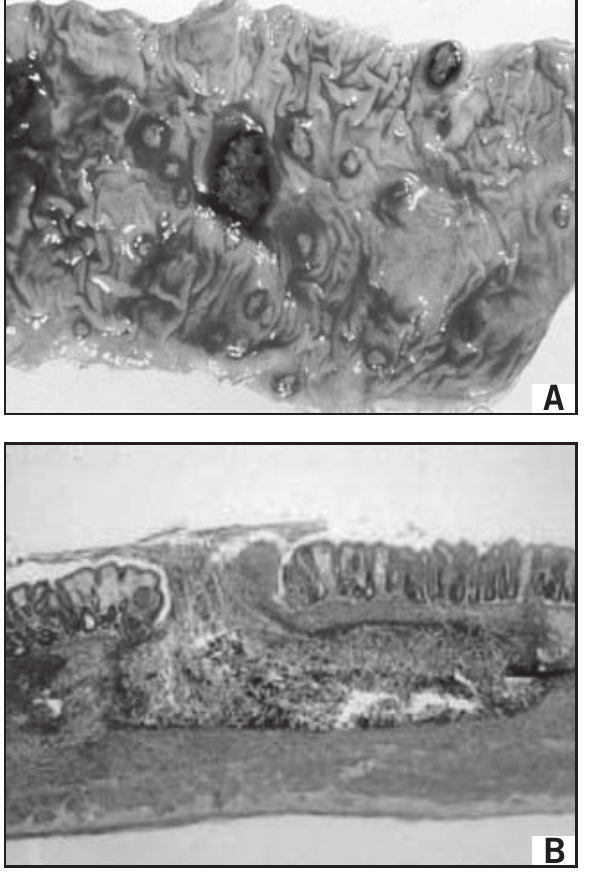
Figura 3 – Ulceração na colite amebiana. A: macroscopia de uma porção do intestino delgado mostrando a patologia da colite amebiana. Observar múltiplas formações ulcerosas. B: histopatologia da mucosa intestinal mostrando ulceração típica causada pela amebíase: úlcera em forma de frasco com um pescoço estreito e uma base ampla. É mostrada ulceração na mucosa com invasão de submucosa